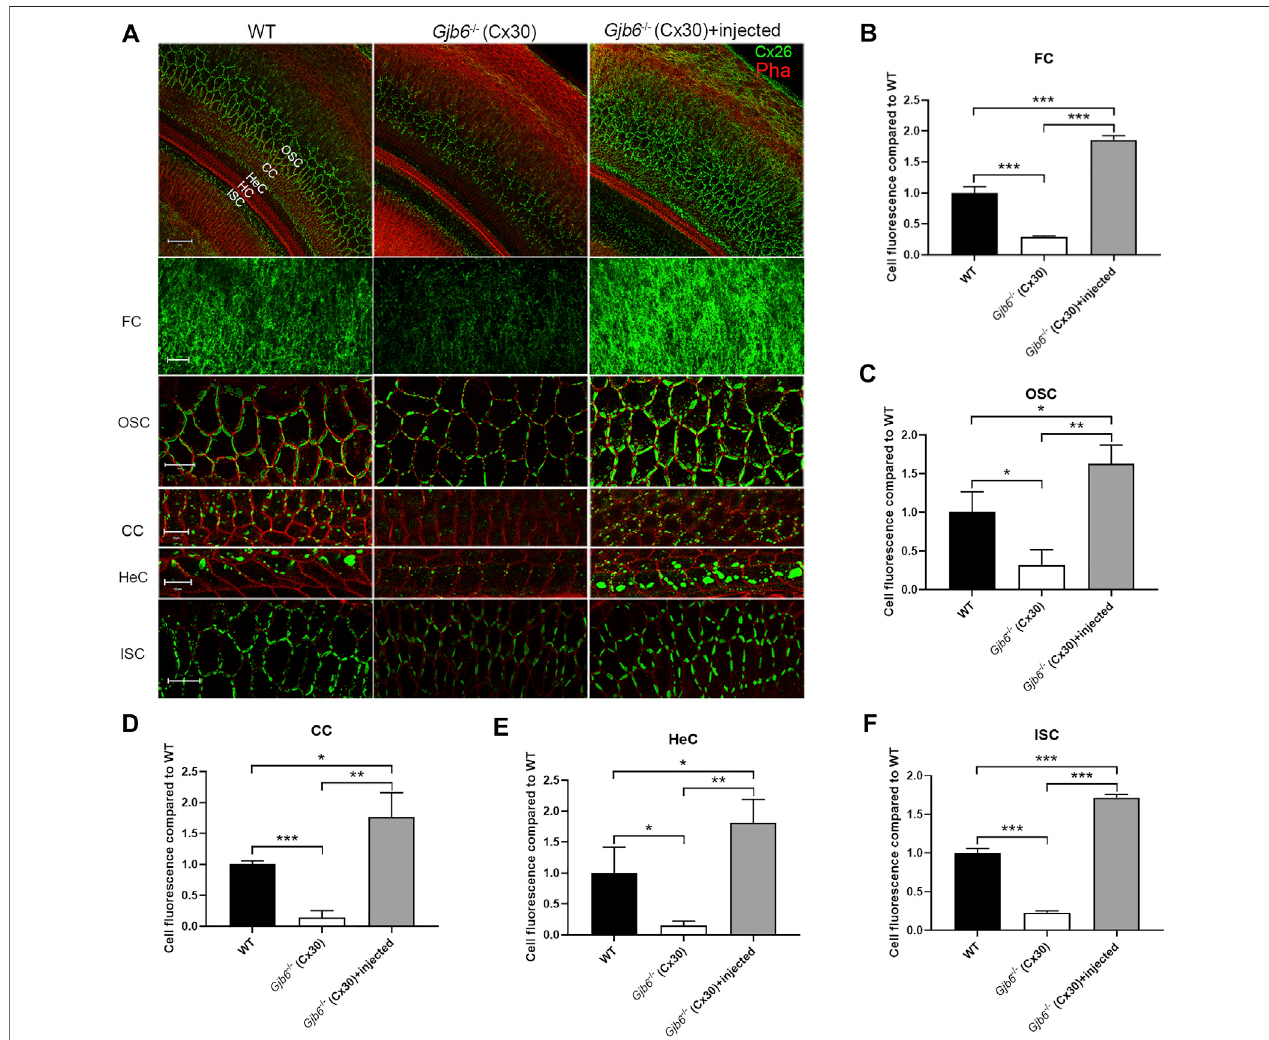
FIGURE 1 | Injection of AAV1-CB7- Gjb2 increased the formation of GJs in FCs, OSCs, CCs, HeCs and ISCs in Gjb6 − / − mice. (A) Immunolabelling of Cx26 in WT, Gjb6 − / − cochlea without or with AAV1-CB7- Gjb2 injection. The fi rst row: Low magni fi cation views of representative confocal images of the C×26 expression in WT, Gjb6 − / − cochlea without injection and Gjb6 − / − cochlea with AAV1-CB7- Gjb2 injection. The second to the last row: High magni fi cation views of C×26 expression in FC in spiral ligament, OSC, CC, HeC and ISC in WT (panels in left column), Gjb6 − / − cochlea without injection (panels in the middle column) and Gjb6 − / − cochlea with AAV1-CB7- Gjb2 injection (panels in the right column). The fi rst to the fi fth row were from P9 mice and the last row were from mice at 1 month post-injection. (B – F) Quanti fi cation of the immuno fl uorescence signal in FC, OSC, CC, HeC and ISC. FC, fi brocytes; OSC, outer sulcus cell; CC, Claudius cell; HeC, Hensen ’ s cell; ISC, inner sulcus cell; HC, hair cell; Pha, phalloidin; Cx26, connexin 26. Scale bar: 50 µm (the fi rst row), 20 µm (the second, third and sixth row), 10 µm (the fourth and fi fth row). Error bars in B-F represent standard deviation of the mean. n = 3 for each group, * indicates p < 0.05, ** indicates p < 0.01, *** indicates p <